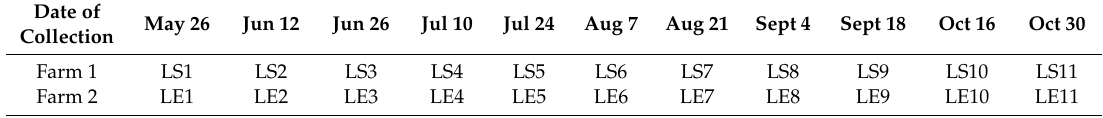
Table 3. Numbering of the Aronia berry samples collected for analysis from two Polish